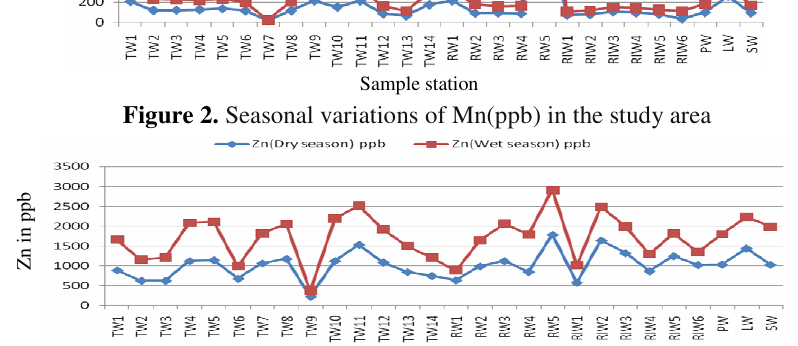
Figure 2. Seasonal variations of Mn(ppb) in the study area